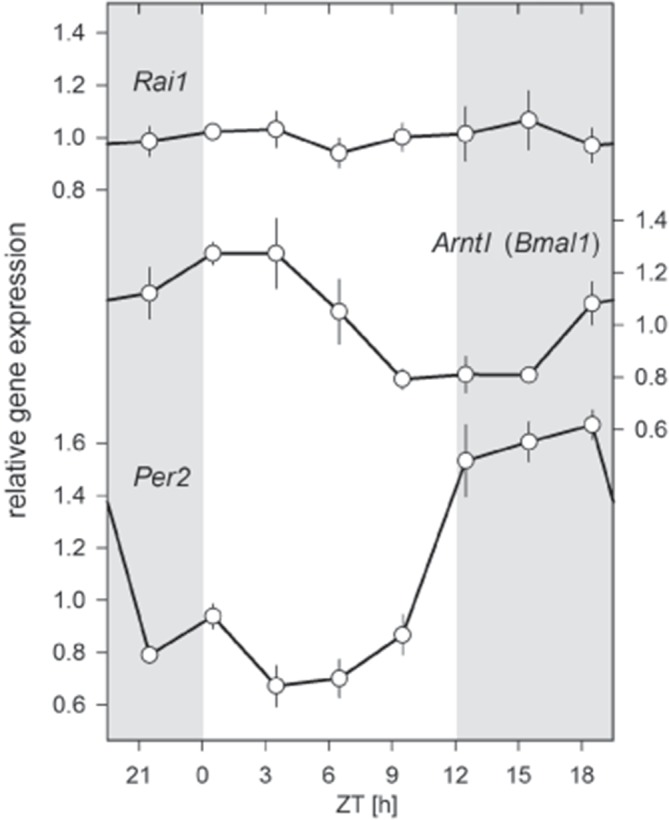
Twenty-four hour brain expression profiles for Rai1, Arntl, (Bmal1), and Per2 in wild-type mice.While Bmal1 and Per2 expression showed their well-known anti-phasic circadian expression profiles, Rai1 expression was remarkable indifferent to time-of-day and lighting condition. Samples were taken at 3 hr intervals (total n = 23; that is, n = 3/interval, except for ZT18: n = 2).